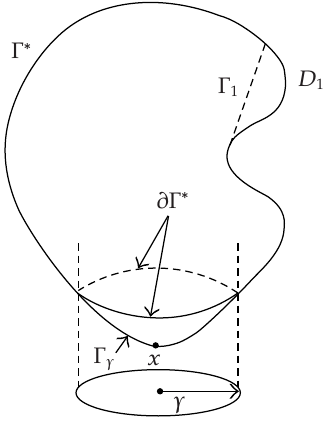
Figure 3.2. Nonconvex